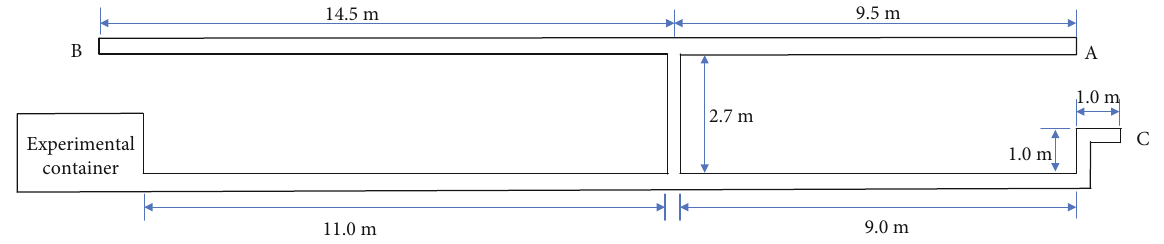
Figure 2: Schematic diagram of the experimental system and the position of the simulated antioutburst